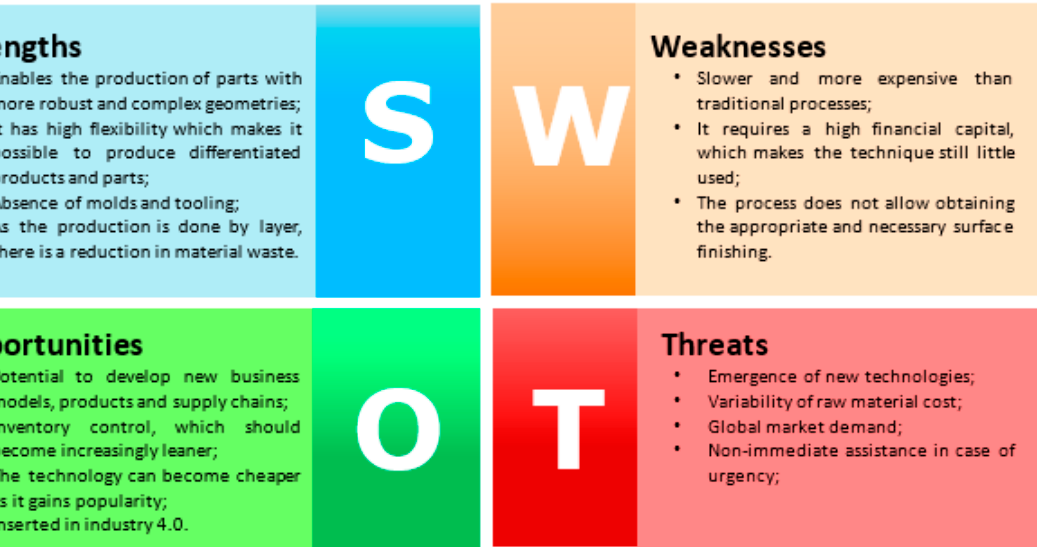
Figure 5. SWOT analysis regarding additive manufacturing.